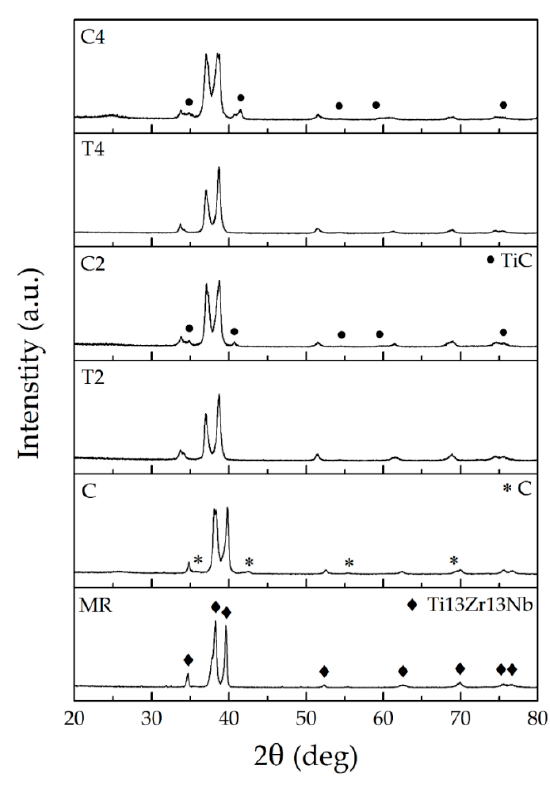
Figure 6. XRD spectra of Ti13Nb13Zr alloy for: MR, C (MR with MWCNTs coating), T2, T4—its alloys after laser treatment, C2, C4—its alloys with MWCNTs coating after laser treatment.